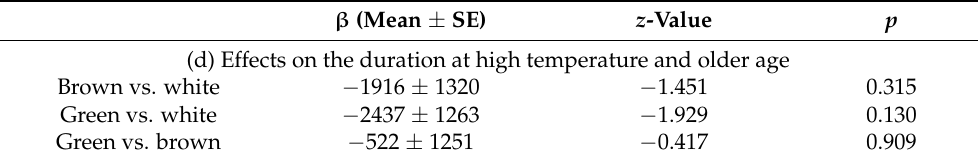
Table 3. Cont. β (Mean ± SE) z -Value p (d) Effects on the duration at high temperature and older age Brown vs. white − 1916 ± 1320 − 1.451 0.315 Green vs. white − 2437 ± 1263 − 1.929 0.130 Green vs. brown − 522 ± 1251 − 0.417